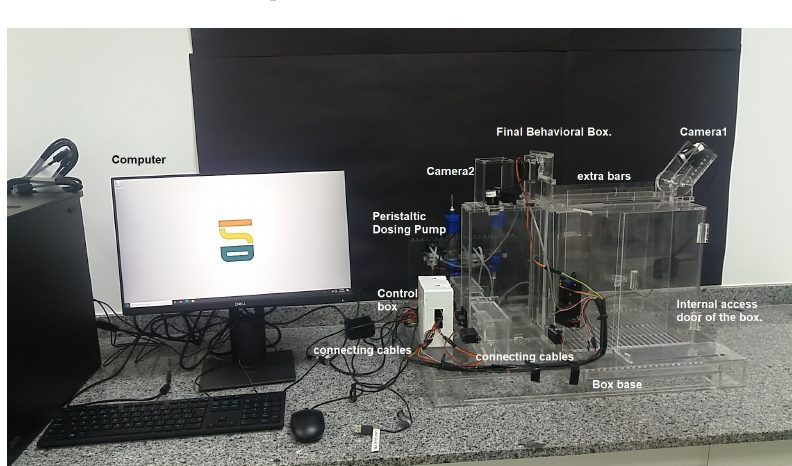
Figure 17. Behavior box working—final